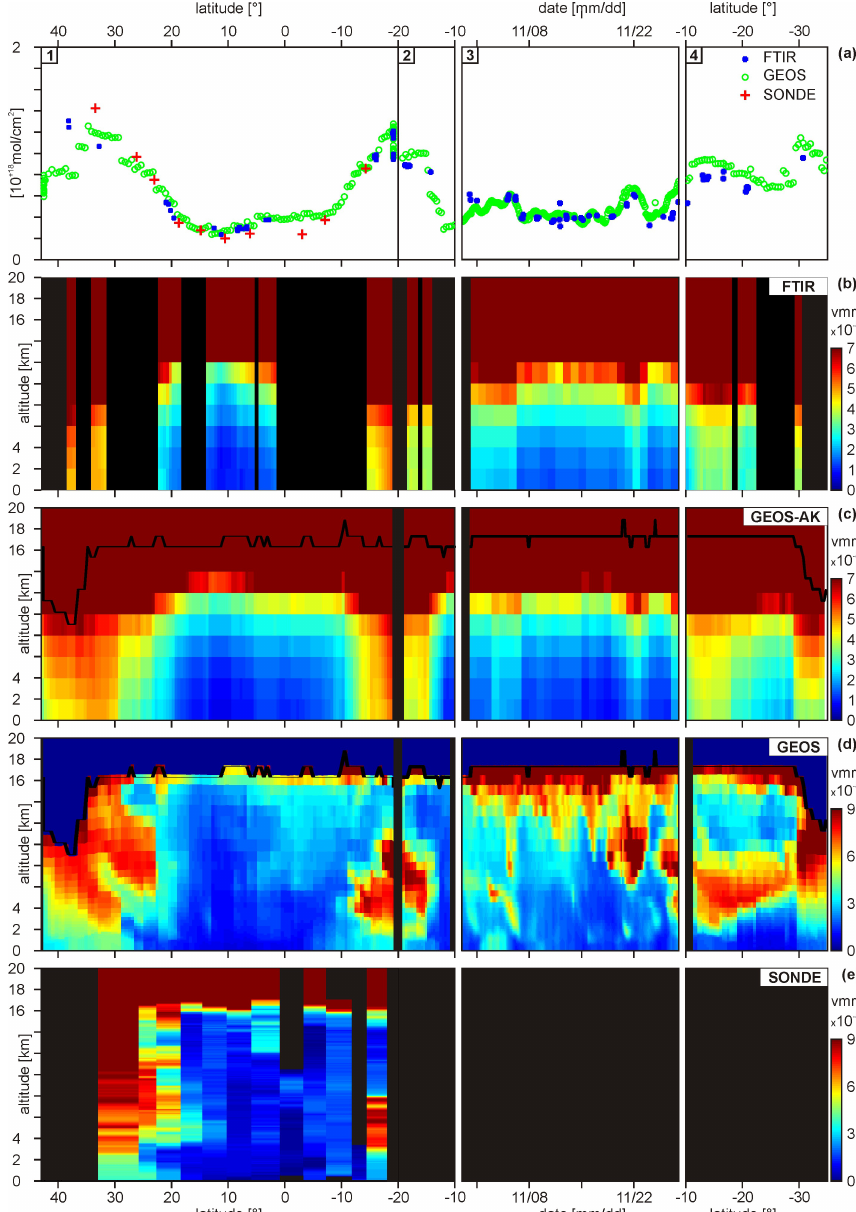
Fig. 5. O 3 distribution during the four sections of the ship campaign with RV Sonne ; (a) tropospheric columns obtained from solar absorption FTIR measurements (blue dots) and O 3 -sonde measurements (red crosses) compared to the GEOS-Chem model (green circles), (b) solar absorption FTIR profiles, (c) GEOS-Chem profiles smoothed with FTIR averaging kernels, (d) raw GEOS-Chem profiles, (e) O 3 -sonde profiles. The black lines in (c) and (d) represent the model tropopause